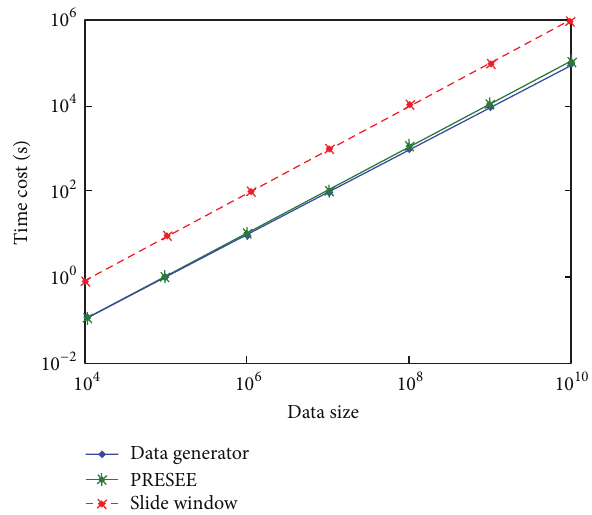
Figure 7: Efficiency and scalability of different algorithms.